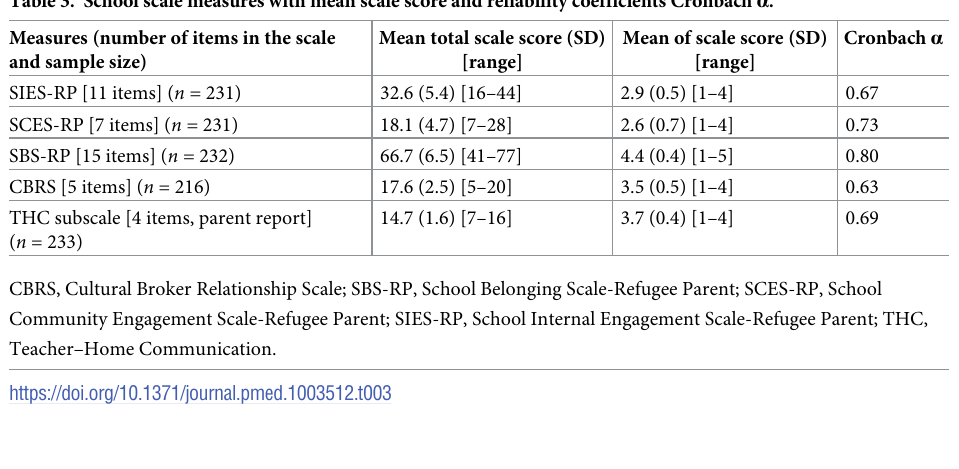
each outcome variable. The VIF for the predictor variables ranged from 1.14 to 2.25. Multicol- linearity tolerance statistics ranged from 0.44 to 0.87. While some predictor variables were sig- nificantly correlated with one another, the maximum value of correlation coefficient r = 0.48